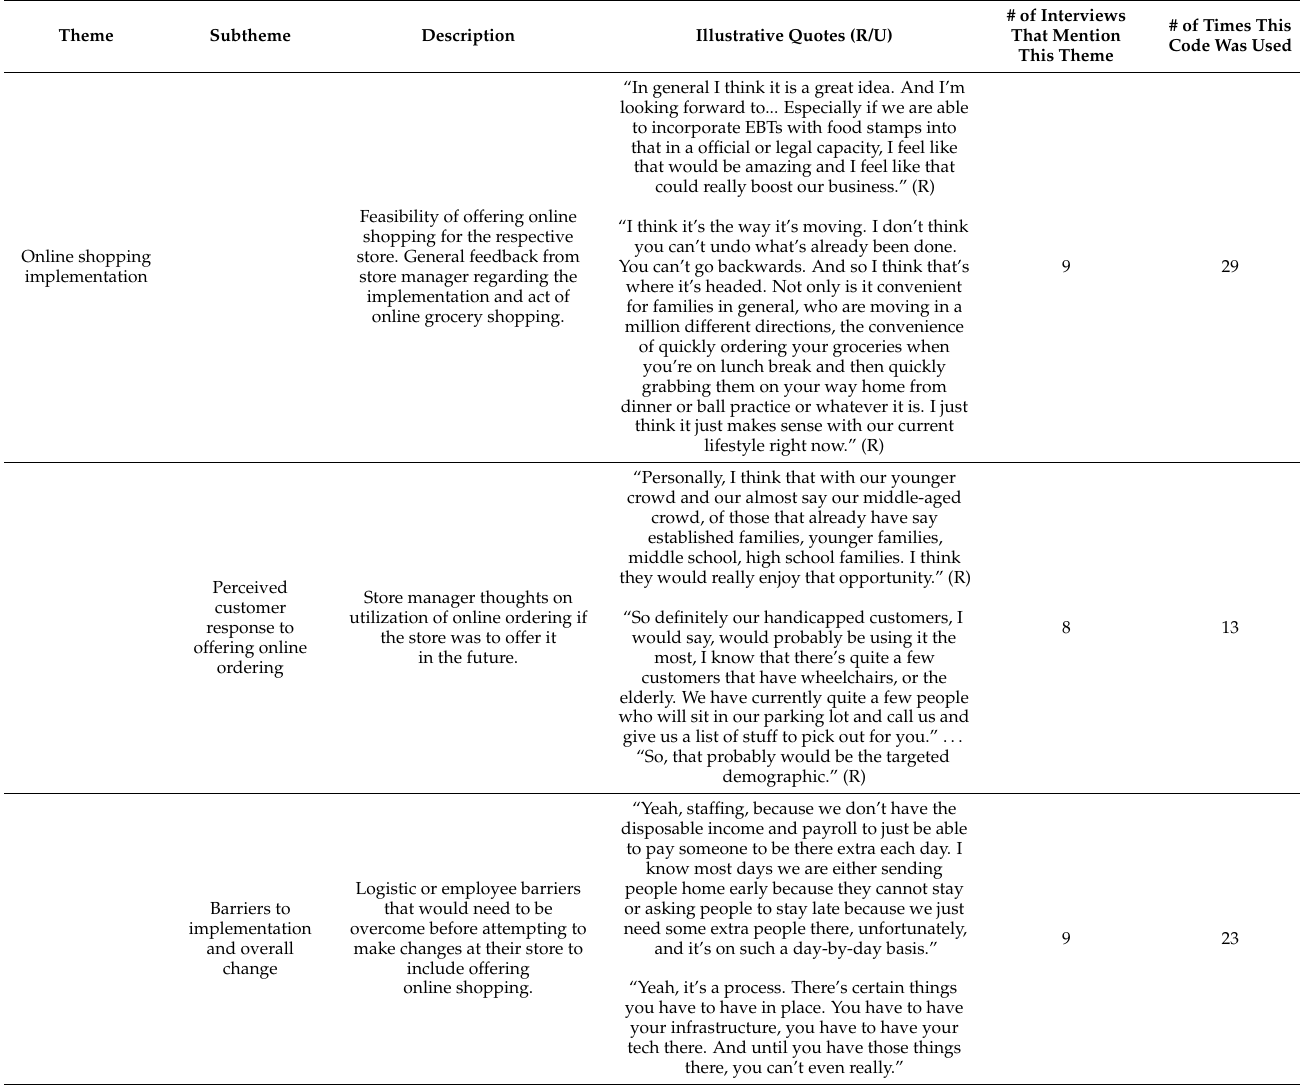
Table 3. Primary emergent themes from qualitative analysis among n = 8 grocery store managers offering brick-and-mortar grocery